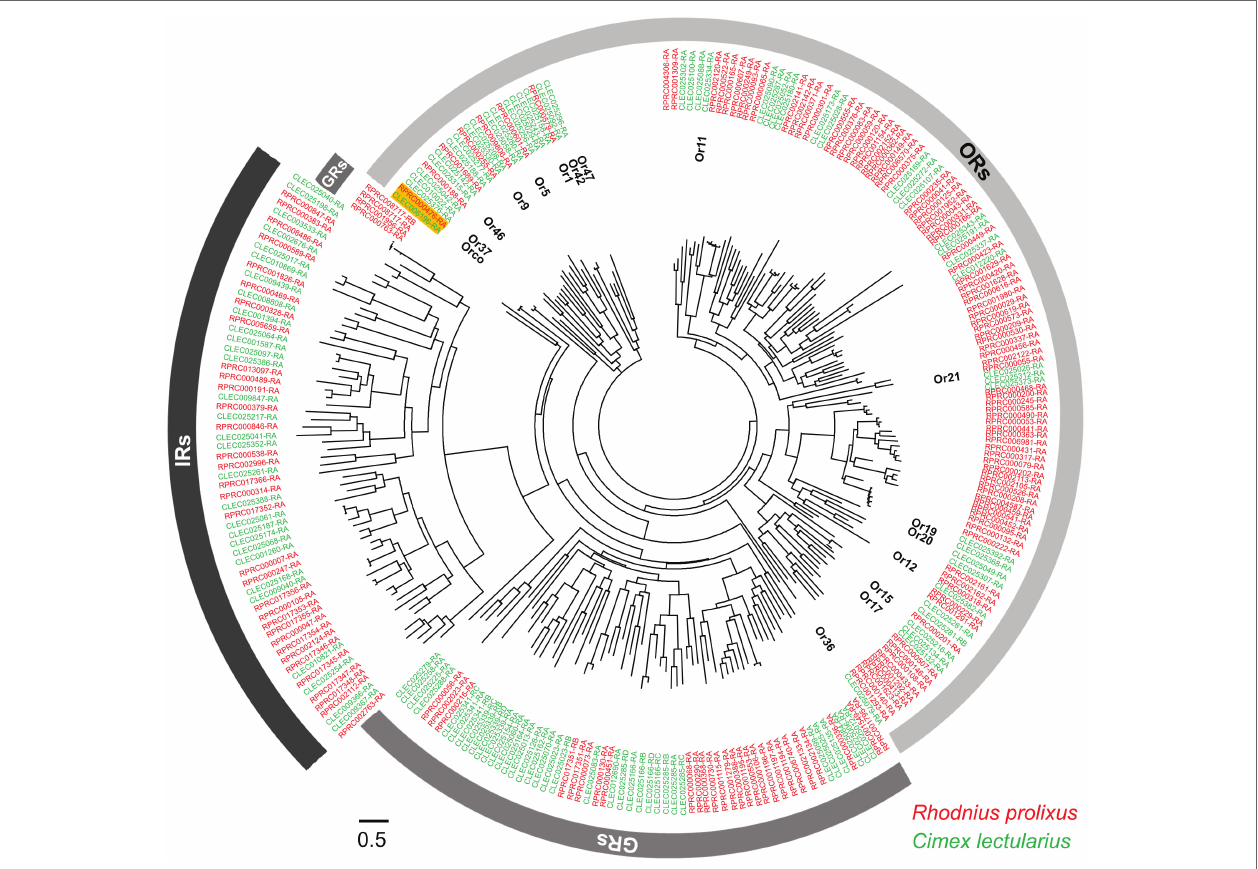
FIGURE 3 | Phylogenetic relationships within the ORs, IRs, and GRs of R. prolixus and C. lectularius . The dendrogram was computed using FastTree based on a MAFFT alignment of 272 amino acid sequences (VectorBase) from R. prolixus (accession number in red color) and C. lectularius (accession number in green color). The accession numbers of two Orco genes are highlighted. Fifteen ORs of C. lectularius that have been tested against around 150 odorants, including human odors and botanical chemical stimuli, are annotated (Liu et al.,